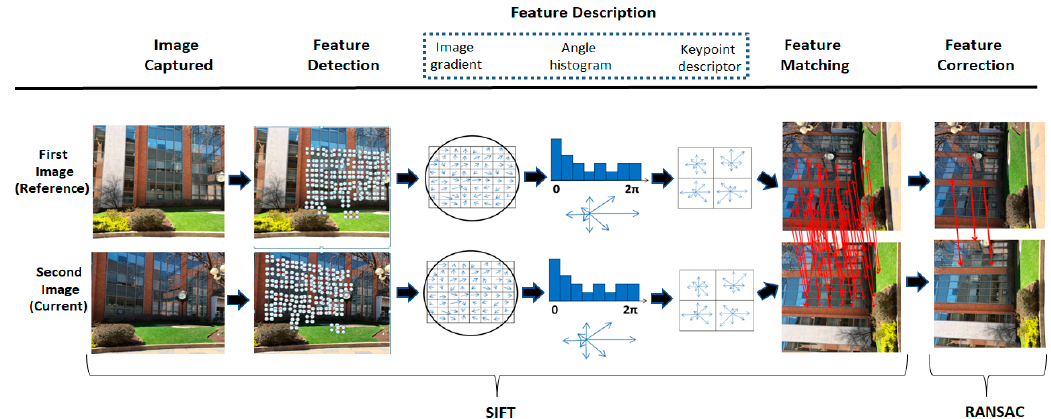
Figure 1. While SIFT detects, describes, and matches the key points, RANSAC filters incorrect matches (Adapted from [1,33]).